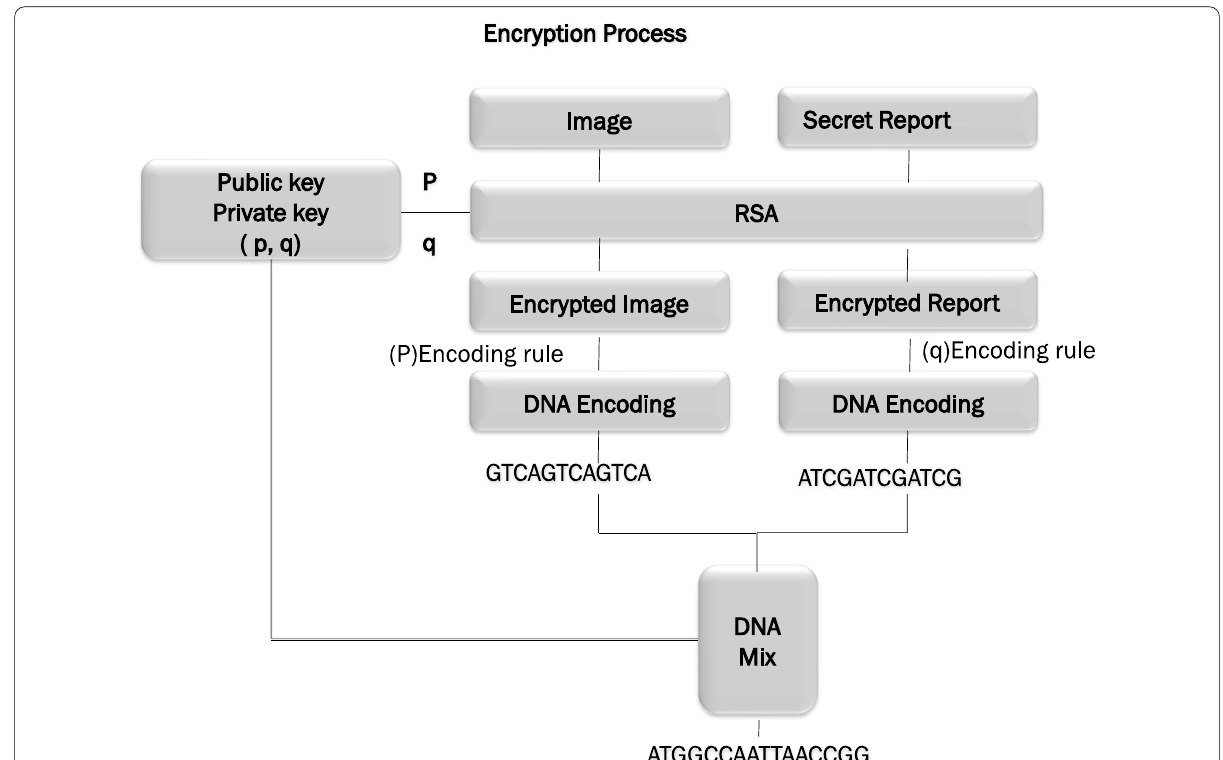
Fig. 1 Encryption process of the proposed cryptographic